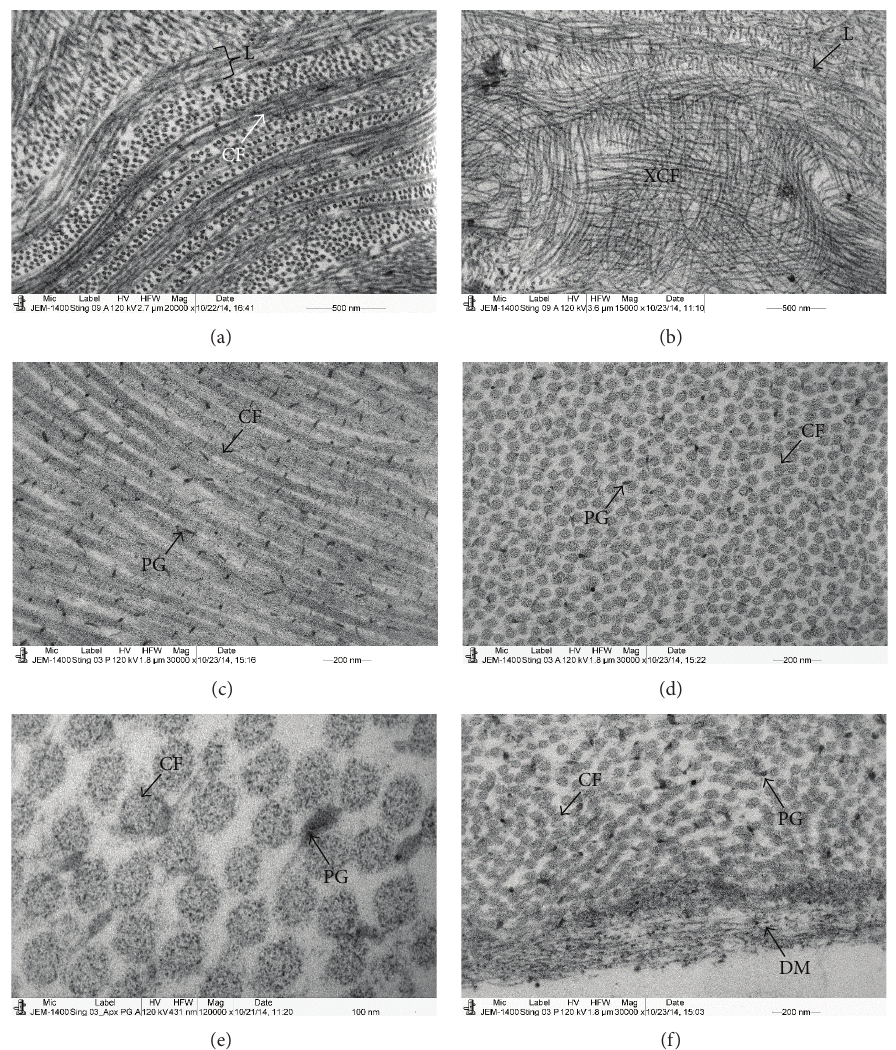
Figure 2: Electron micrograph of collagen fibrils (CF) and proteoglycans (PGs) of stingray cornea; (a) part of the anterior stroma showing thin lamellae containing thin CF (20 nm); (b) part of the anterior stroma showing and orthogonal arrangement of the CFs (XCF); (c) part of the middle stroma showing longitudinally running CFs decorated with PGs; (d) part of the middle stroma showing cross section of uniformly distributed CF and PGs; (e) cross section of CF at high magnification showing microfibrils within CF; (f) posterior part of the stroma showing CF, PGs, and DM composed of microfibrils. BM: basement membrane, BW: Bowman’s layer, DM: Descemet’s membrane L: lamellae, CF: collagen fibrils, PG: proteoglycans, and XCF: orthogonal arrangement of the